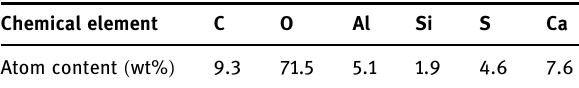
Table 4: EDS analysis of PA modi fi ed mortars from Figure 9 ( c ) ( wt% ) Chemical element